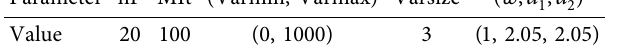
Table 2: Values of the PSO algorithm’s parameters.